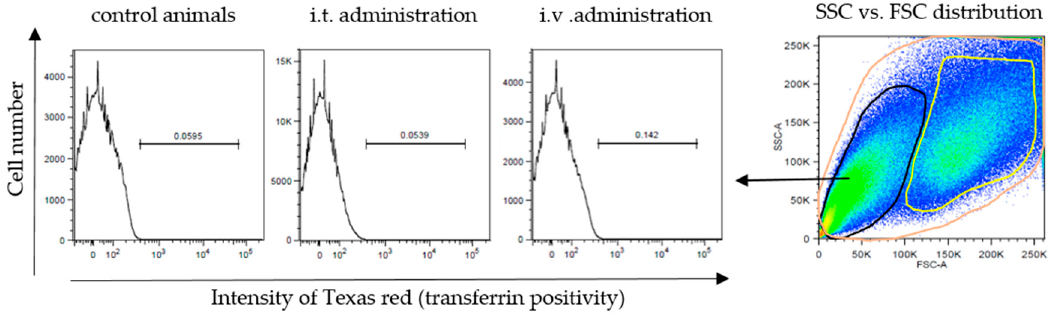
Figure A3. Texas Red signal in debris/erythrocytes fraction of unfiltered spleen samples from animals administered with NDA135b.